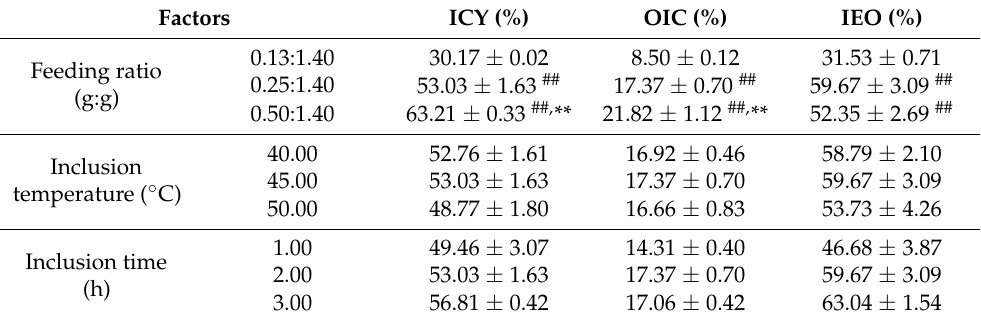
Values represent the mean ± SD of three the independent measurements. Three factors were selected as the main investigation aspects: (a) feeding ratio (the ratio of essential oil to β -CD, g:g): 0.13:1.40, 0.25:1.40, and 0.50:1.40;